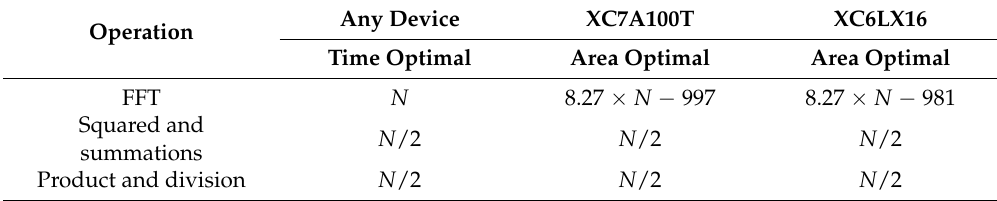
Table 4. Number of clock cycles needed to perform each